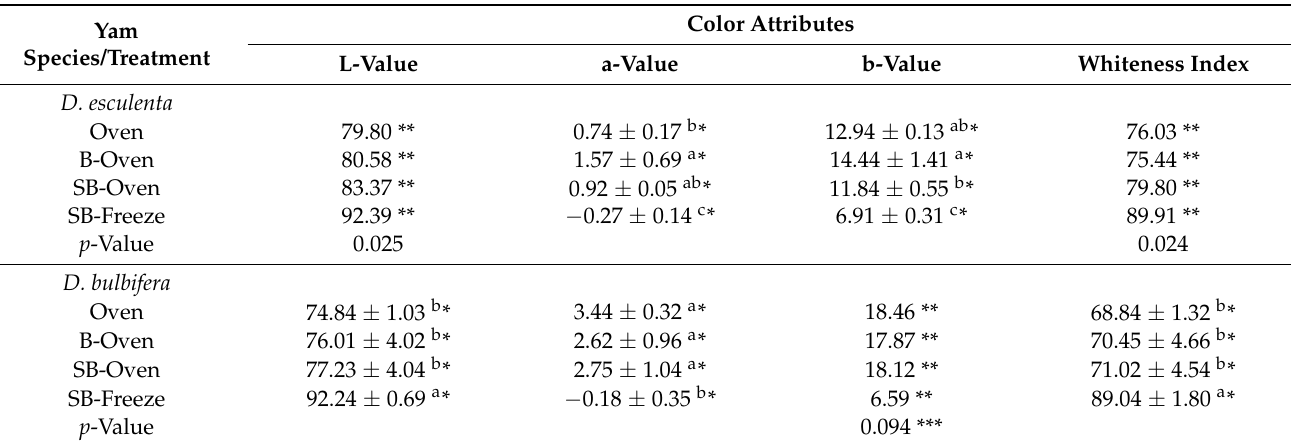
Table 3. Color of yam flour prepared with different processing